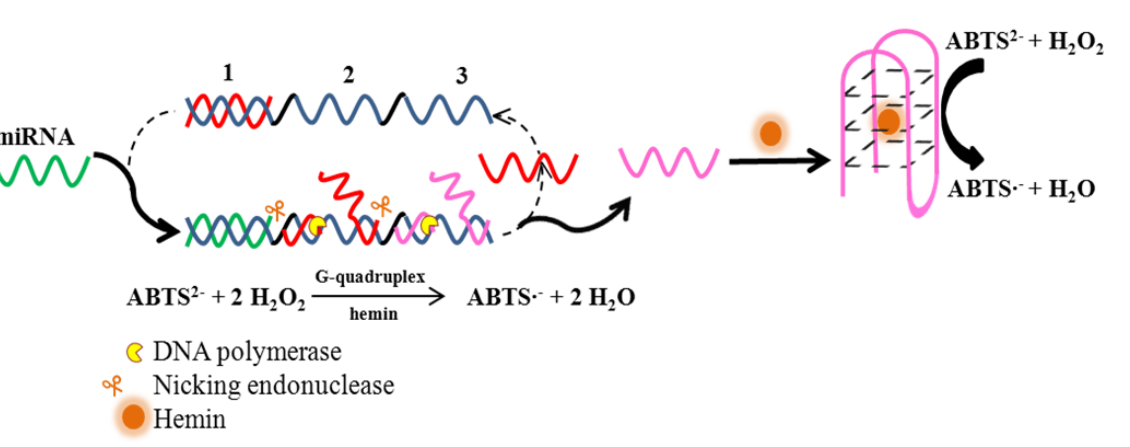
Figure 5. Schematic illustration of miRNA detection based on isothermal exponential amplification-assisted generation of catalytic G-quadruplex DNAzyme. Below: the reaction schemes of ABTS 2 − catalysed by G-quadruplex DNAzyme in the presence of hemin and H O . Adopted and modified according to Wang et al. 2 2